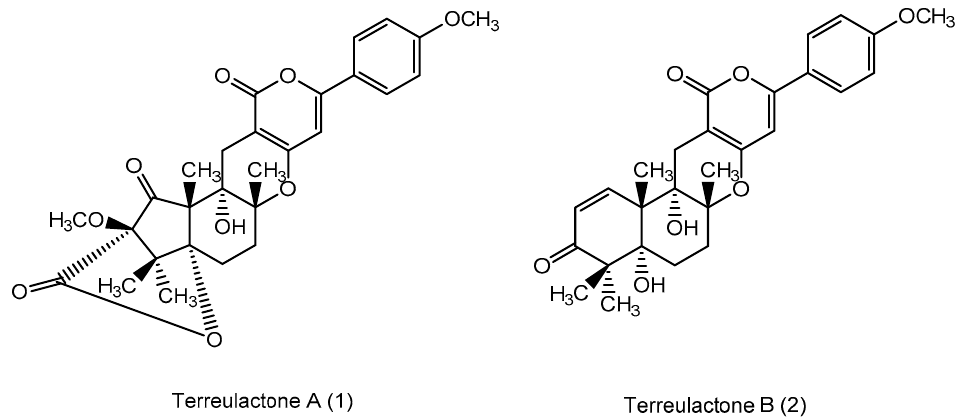
Figure 2. Structures of the terreulactones A and B.